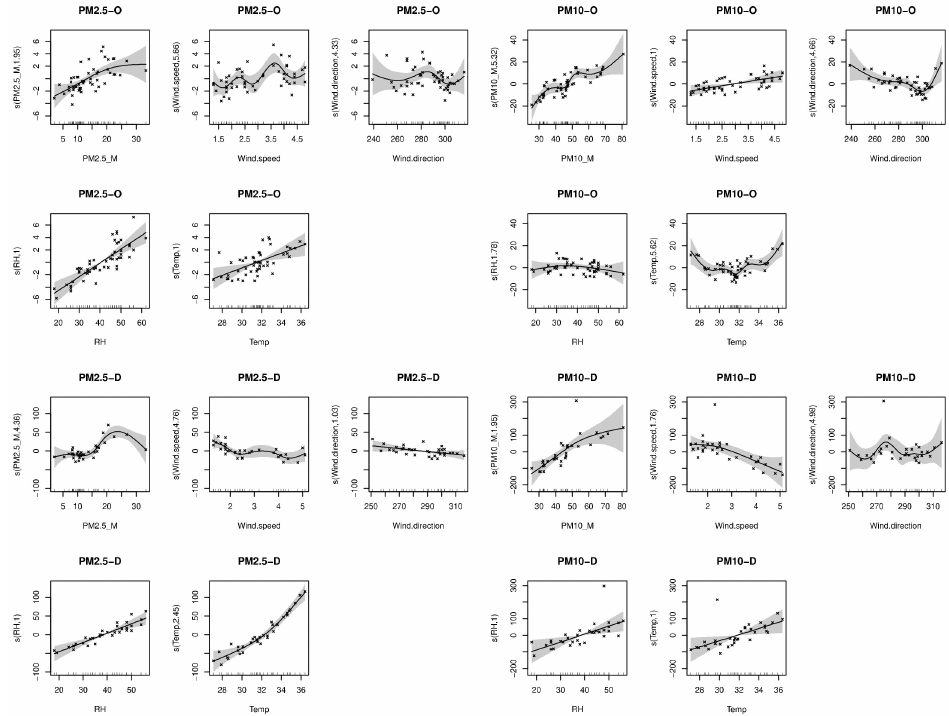
Figure 11. Scatter plot linearity test between the Dylos, OPC-N3 sensors and the satellite model, along with environmental parameters (PM_D = Dylos readings, PM_O = OPC-N3 readings, PM_M = TEOM readings, RH = Relative